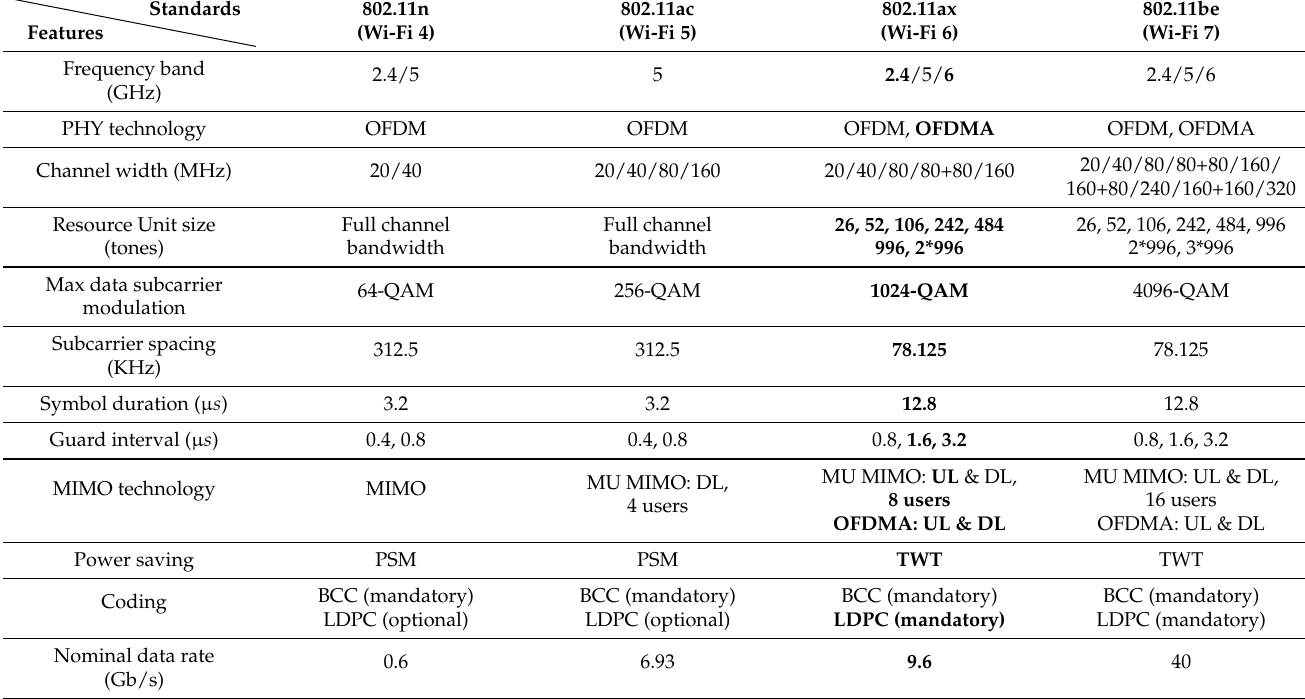
Table 9. PHY and MAC layer specifications for Wi-Fi 4 to Wi-Fi